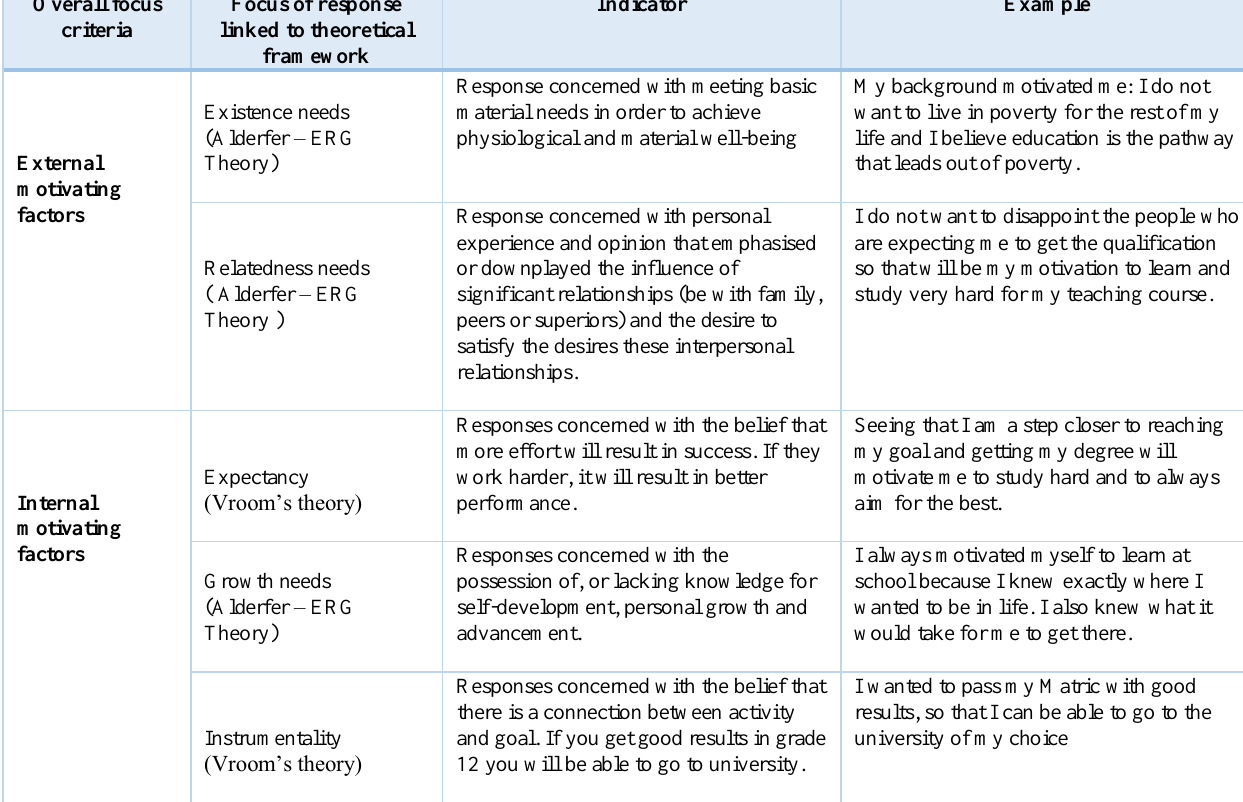
Table 1 Table Showing Differing Levels of Motivational Theories